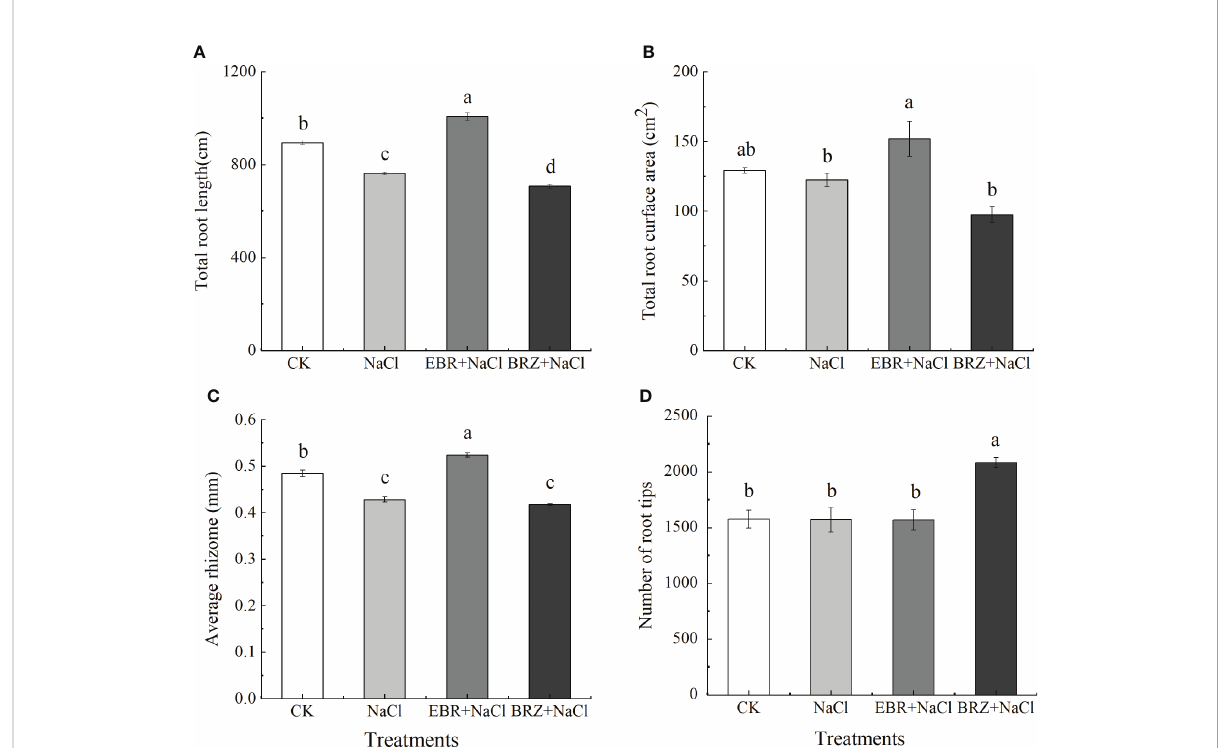
FIGURE 2 Effect of exogenous EBR on total root length (A) , total root surface area (B) , average rhizome (C) , and number of root tip (D) of cucumber seedlings under salt stress. Data are means ± SE of three replicates. Different letters indicate signi fi cant differences at P < 0.05 according to Duncan ’ s multiple range